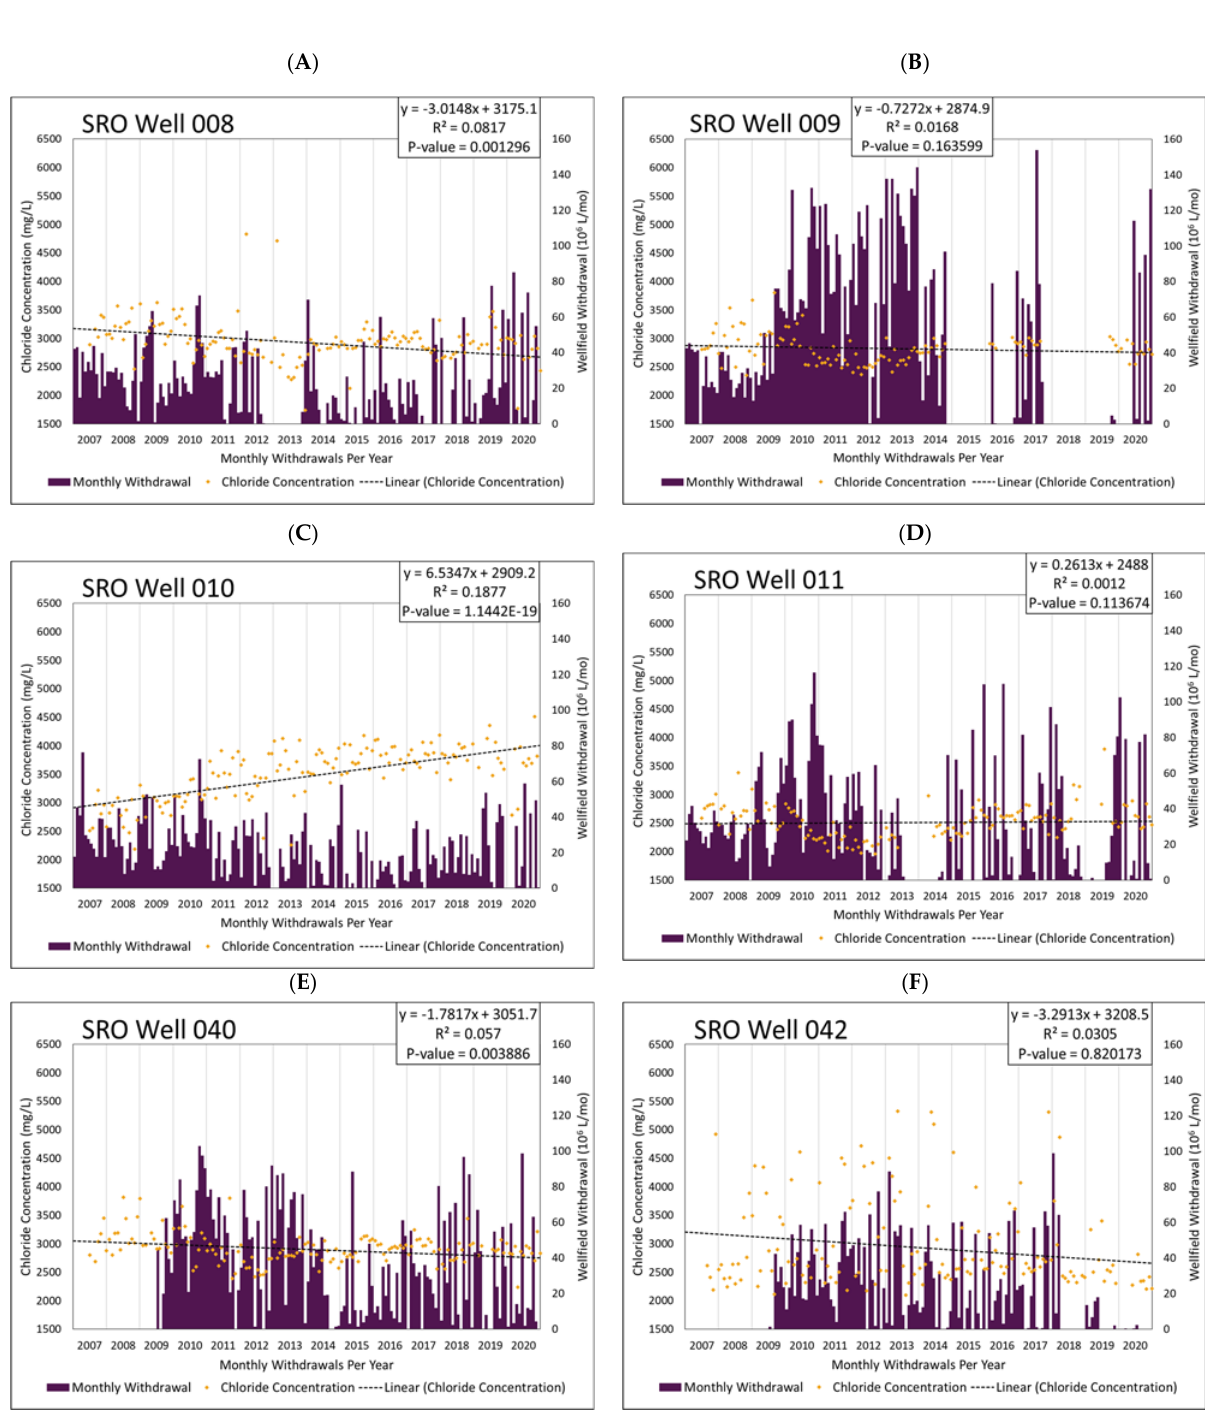
Figure 6. Plots of dissolved chloride concentrations with time, monthly cumulate pumping, the calculated values of R 2 and p -values and the regression equations for the trend line for the Lower Hawthorn Aquifer production wells. The scatter plots of the dissolved chloride concentrations with time show very low R 2 values. Only half (50%) of the linear regression-based trend lines meet the test of statistical significance as indicated by p -values of less than 0.05. Of the six wells, four show a downward trend in dissolved chloride concentration and two show an upward